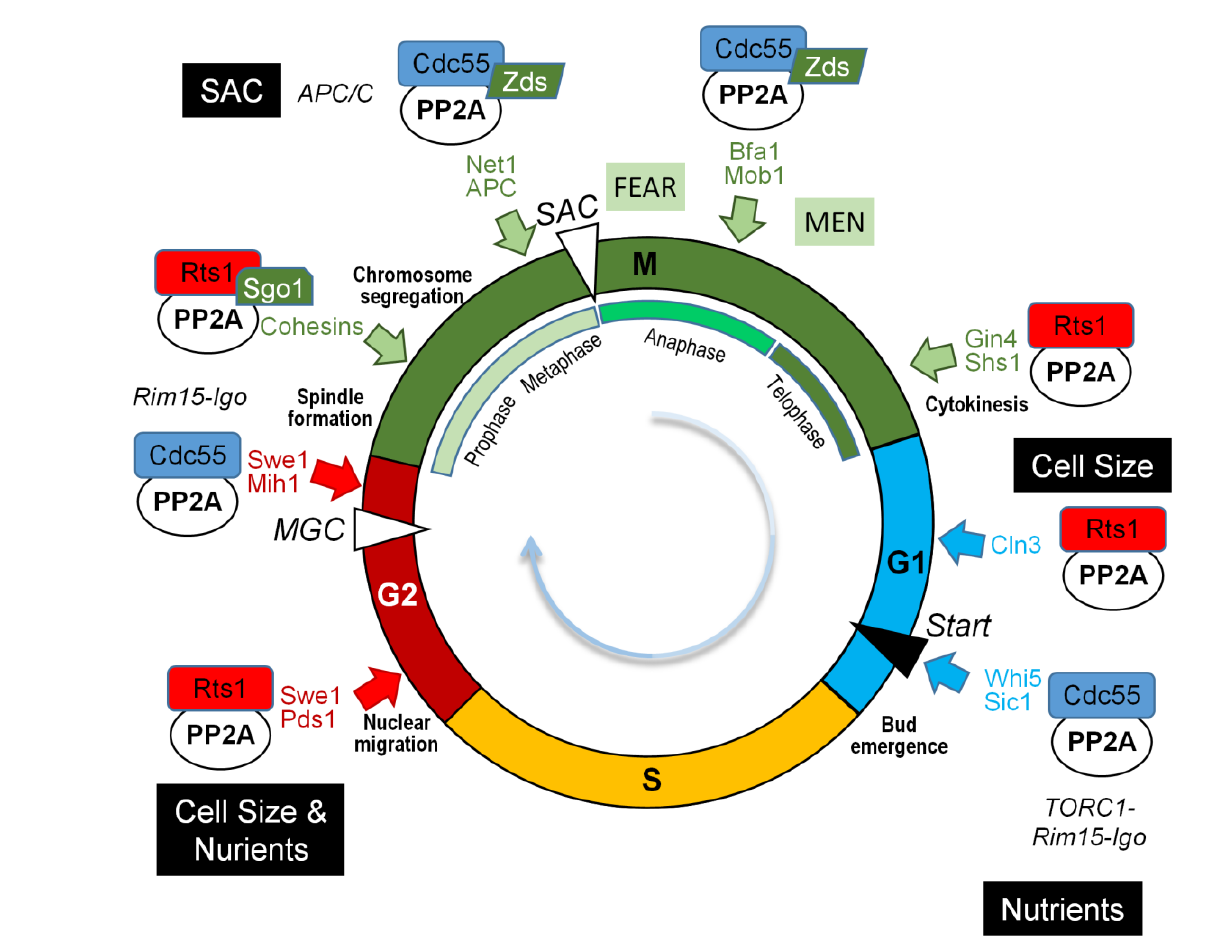
FIGURE 8: Multiple roles of PP2A in cell cycle. The cartoon shows the different combinations of PP2Ac and its regulatory subunits and their role in different points of the cell cycle. Relevant substrates are also annotated with the same color code than that the correspond- ing phase of the cell cycle. SAC, Spindle Assembly Checkpoint; MGC, Morphogenetic